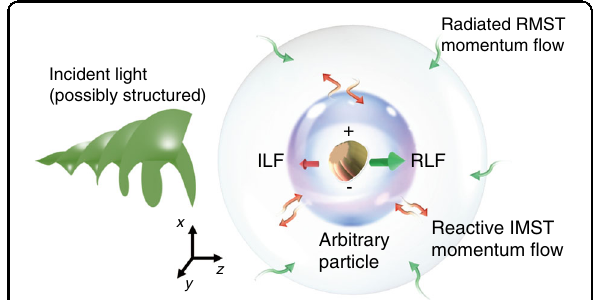
Fig. 1 Schematic view of the CMST concept. The size of the particle, near fi eld and far fi eld region are adjusted for the ease of reading. Incident light, possibly having special fi eld structures, illuminates and polarizes a particle. Such interaction induces both real and imaginary optical force, i.e., ILF and RLF that results in the reactive IMST momentum fl ow and radiated RMST momentum fl ow, respectively.